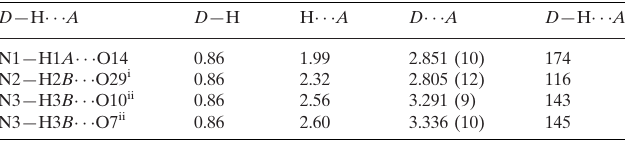
Hydrogen-bond geometry (A˚ , (cid:2)